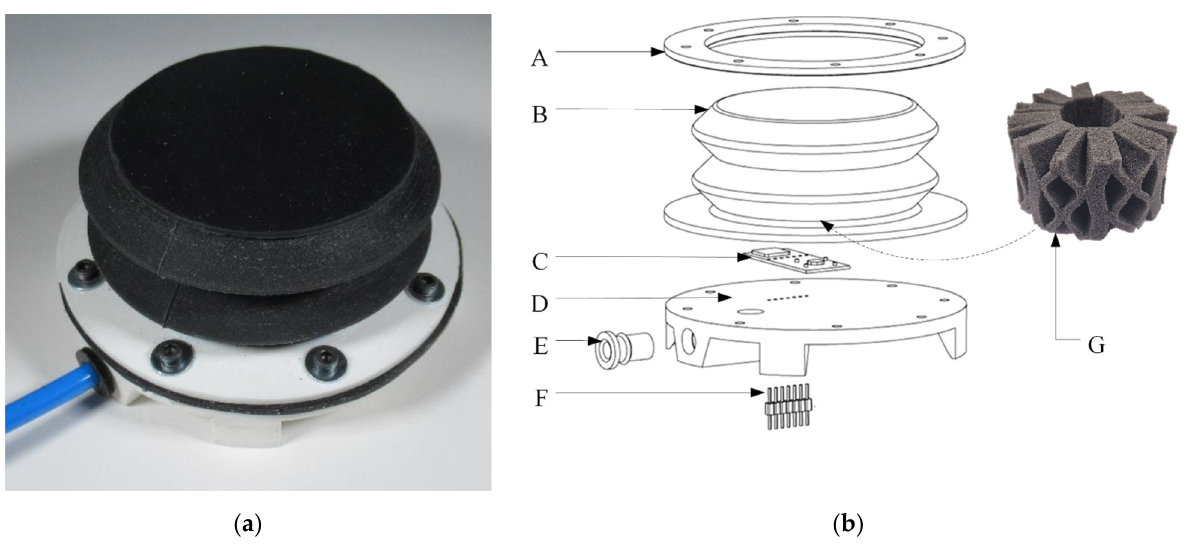
Figure 1. The soft robotics module. ( a ) The module; ( b ) exploded view of the module with A— ring, B—bellow, C—sensors breakout, D—base plate, E—pneumatic fitting, F—male header, and G—Octaspring.